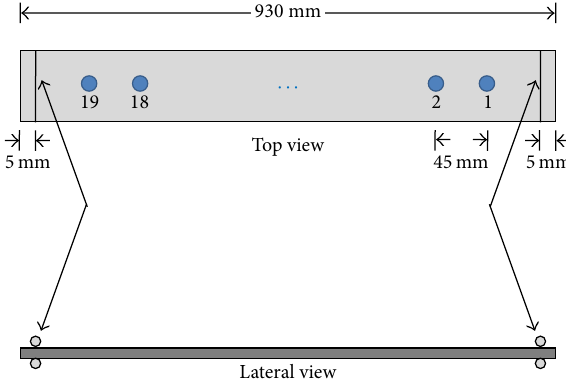
Figure 4: Beam schematic